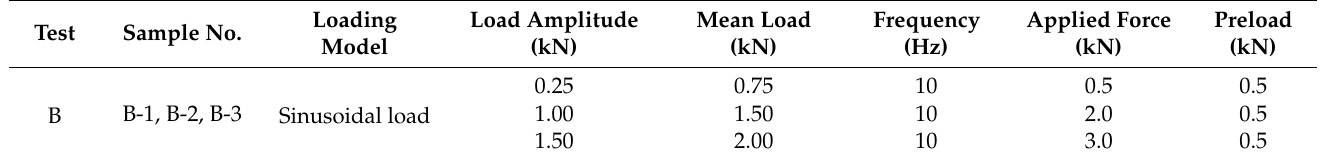
Table 5. Loading scheme of Test B.